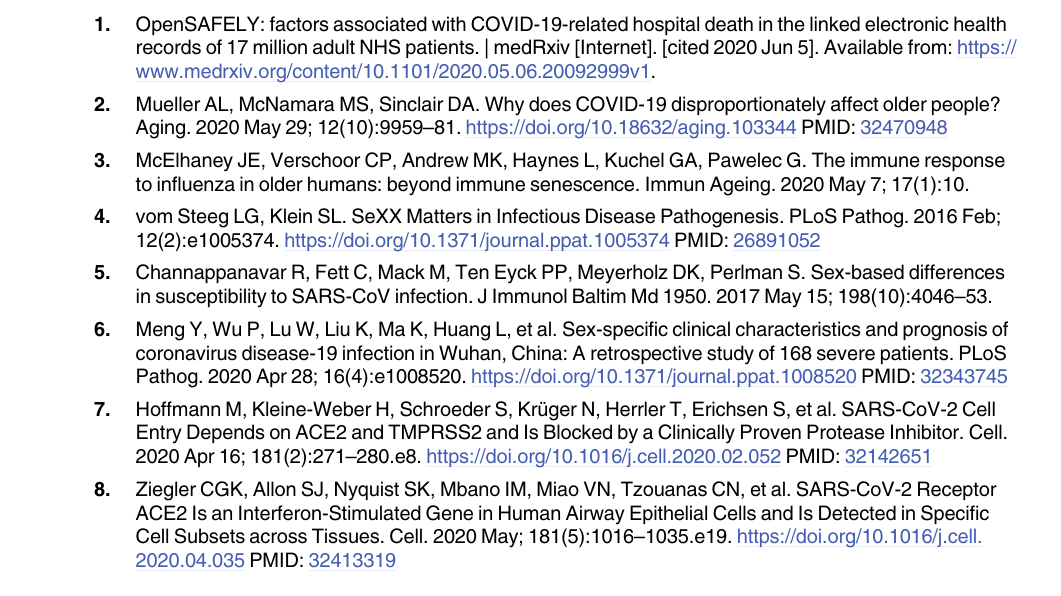
S1 Table. DE genes in SARS-CoV-2-positive samples relative to negative. S2 Table. DE genes in SARS-CoV-2 high viral load samples relative to low viral